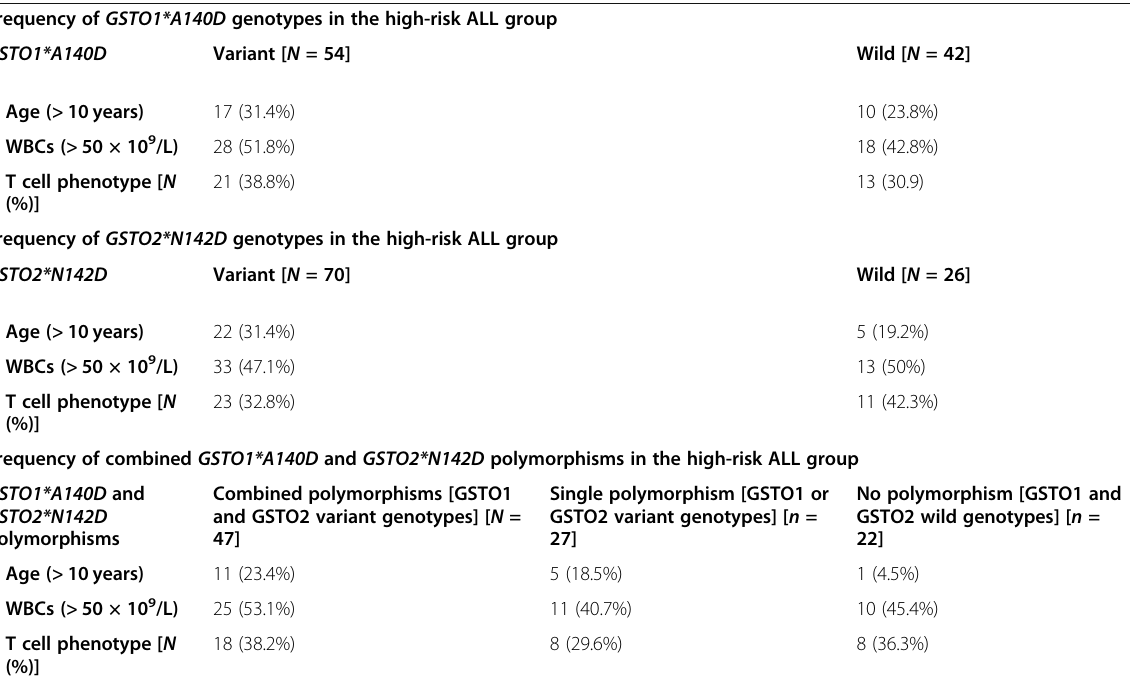
Table 4 The frequency of GSTO1*A140D and GSTO2*N142D polymorphisms in the high-risk ALL group Frequency of GSTO1*A140D genotypes in the high-risk ALL